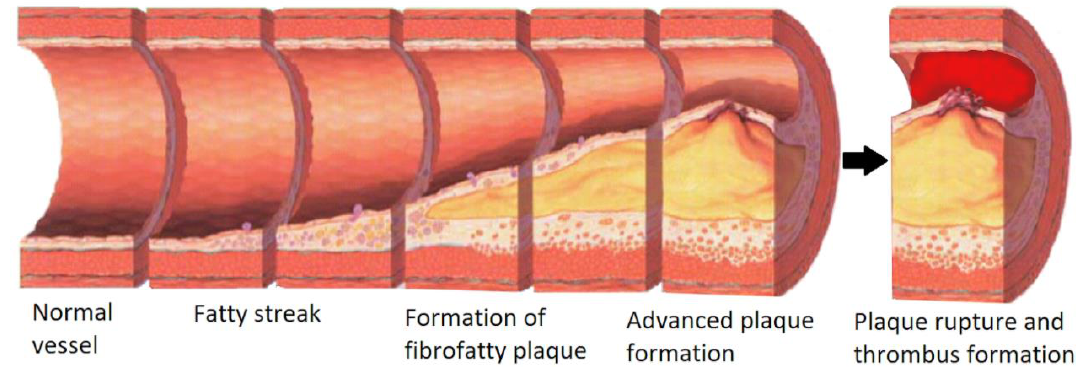
Figure 1. From left to right, Normal healthy vessel, Fatty streak formation, the formation of fibrofatty plaque into an advanced unstable plaque narrowing the lumen of the blood vessel. Then unstable plaque rupture and thrombosis. Adapted from Nicholas Patchett under CC BY-SA 4.0.